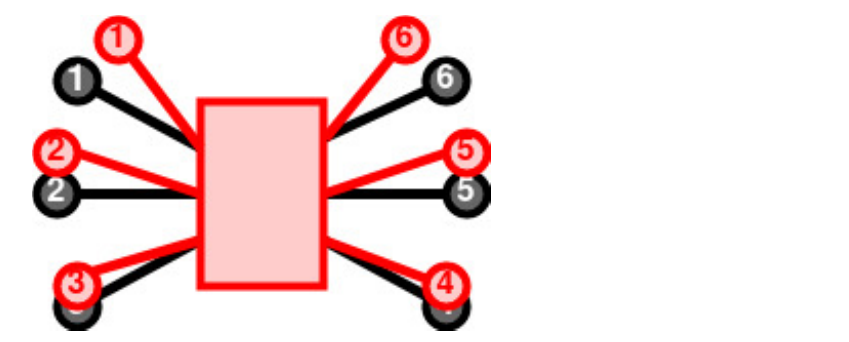
Figure 3. Comparison between the position of the legs before (gray) and after (red) the optimization through the genetic algorithm. Positions specified in Table 1. Table 1. Variation of the position of each joint and suction cup after the